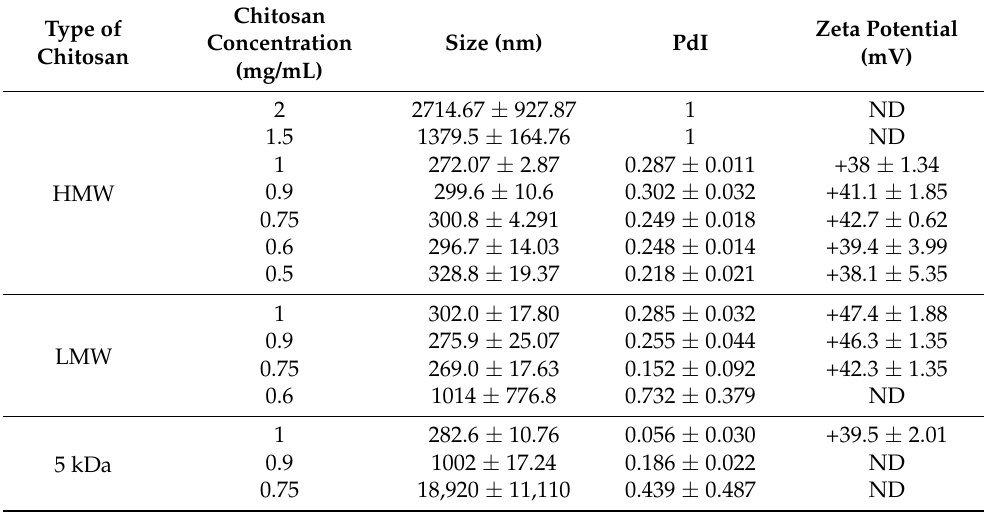
Table 2. Average size, PdI and zeta potential of HMW, LMW and 5 kDa chitosan/SBE- β -CD/ quercetin delivery systems for various ratios. The values are representative of the media obtained in three independent assays (n = 3). Abbreviations: ND = Not